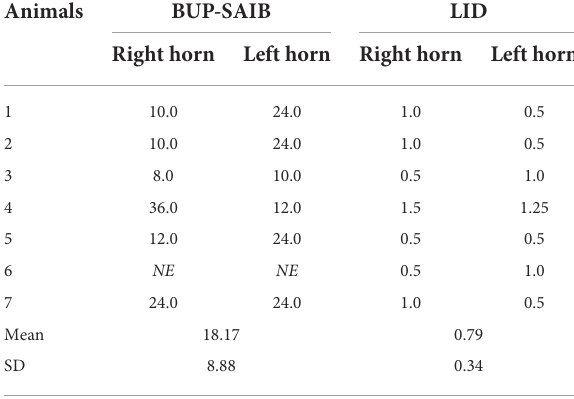
TABLE 1 Duration of cornual nerve block (hours) following administration of bupivacaine-SAIB formulation (5% bupivacaine, n